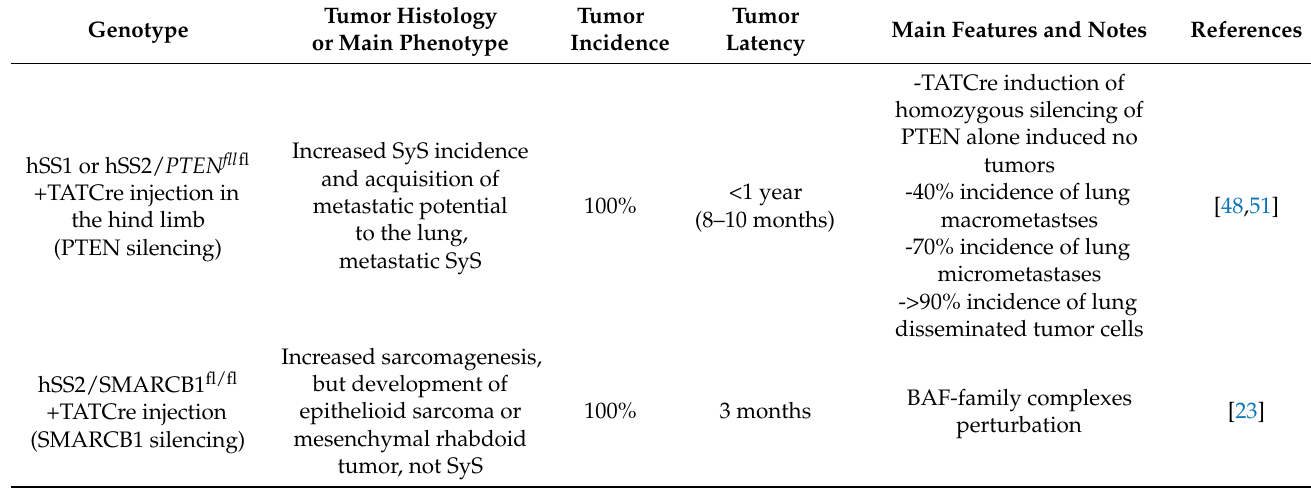
Table 3. Combination of conditional SyS mouse models and tumor suppressor gene